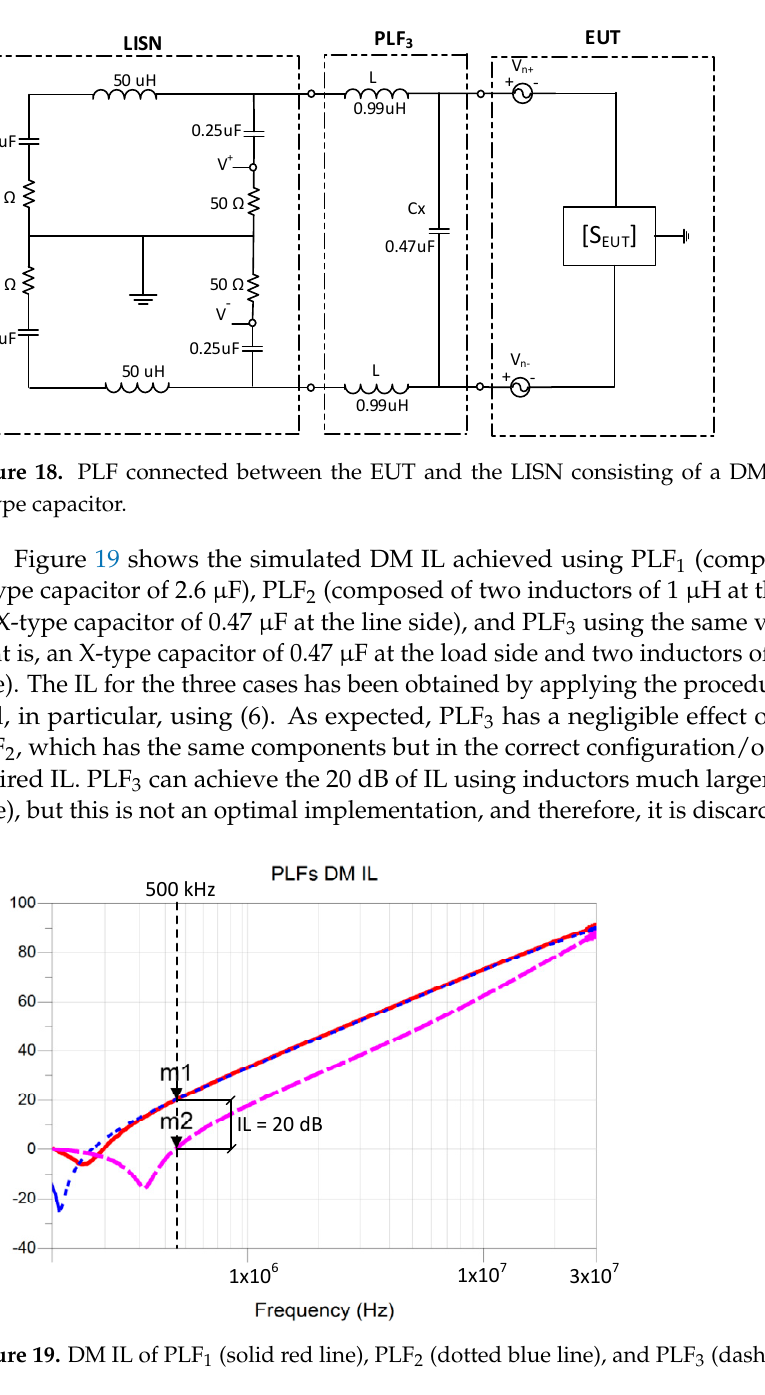
Figure 19. DM IL of PLF 1 (solid red line), PLF 2 (dotted blue line), and PLF 3 (dashed pink line).